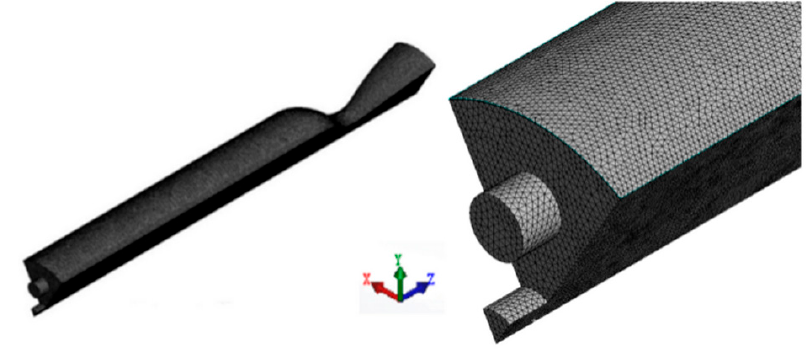
Figure 6. Combustion flow field mesh and local enlargement.